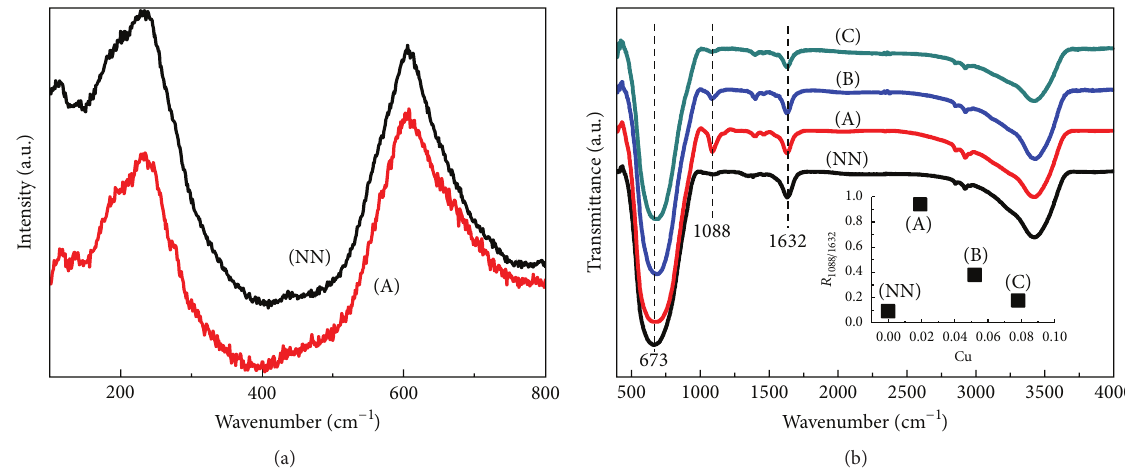
Figure 2: (a) Raman and (b) FTIR spectra of NN, A, B, and C. The inset in (b) is the normalized intensity of peak at 1088 to 1632 cm −1 as a function of Cu